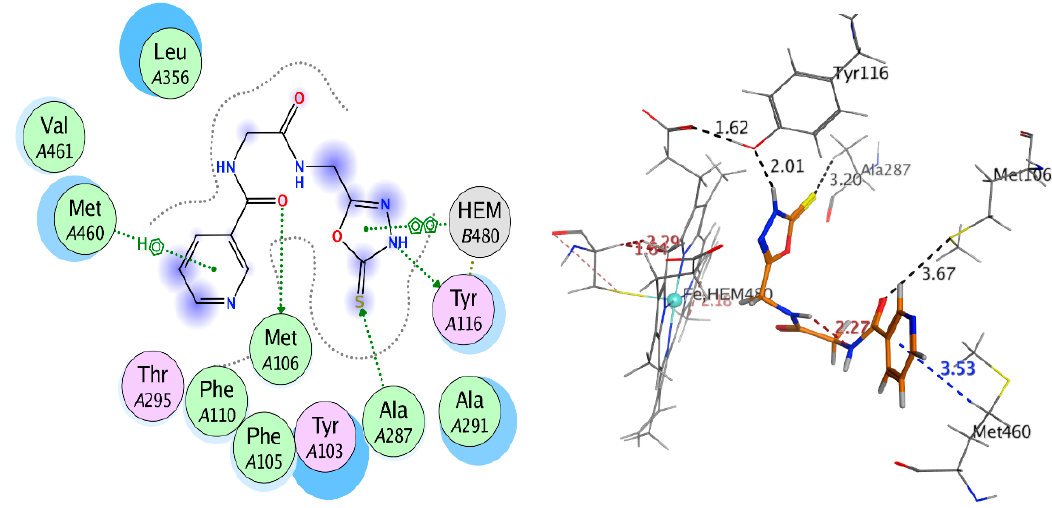
Molecules 2020 , 25 , x Figure 7. 2D and 3D interaction of compound 8 with 3GW9. Figure 7. 2D and 3D interaction of compound 8 with 3GW9.